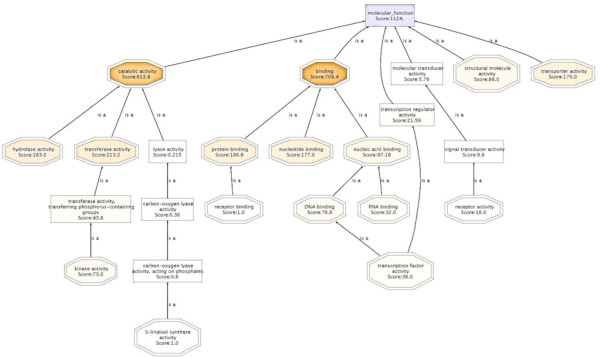
A Directed Acyclic Graph (DAG) visualizing the hierarchical structure of the Gene Ontology (GO) in inoculated kumquat leaves. Children that represent a more specific instance of a parent term have 'is a' relationship to the parent. The darker the color of the node the more number of Blast hits and the higher annotation score it has. All nodes contain the hit annotation scores in numbers.